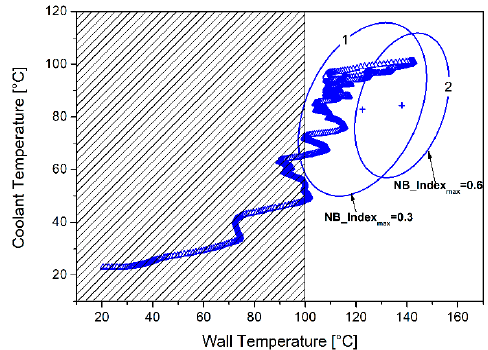
Figure 10. Coolant flow rate ( a ), NB_Index ( b ), wall ( c ), and coolant ( d ) temperature when the controller operates with low boiling levels.